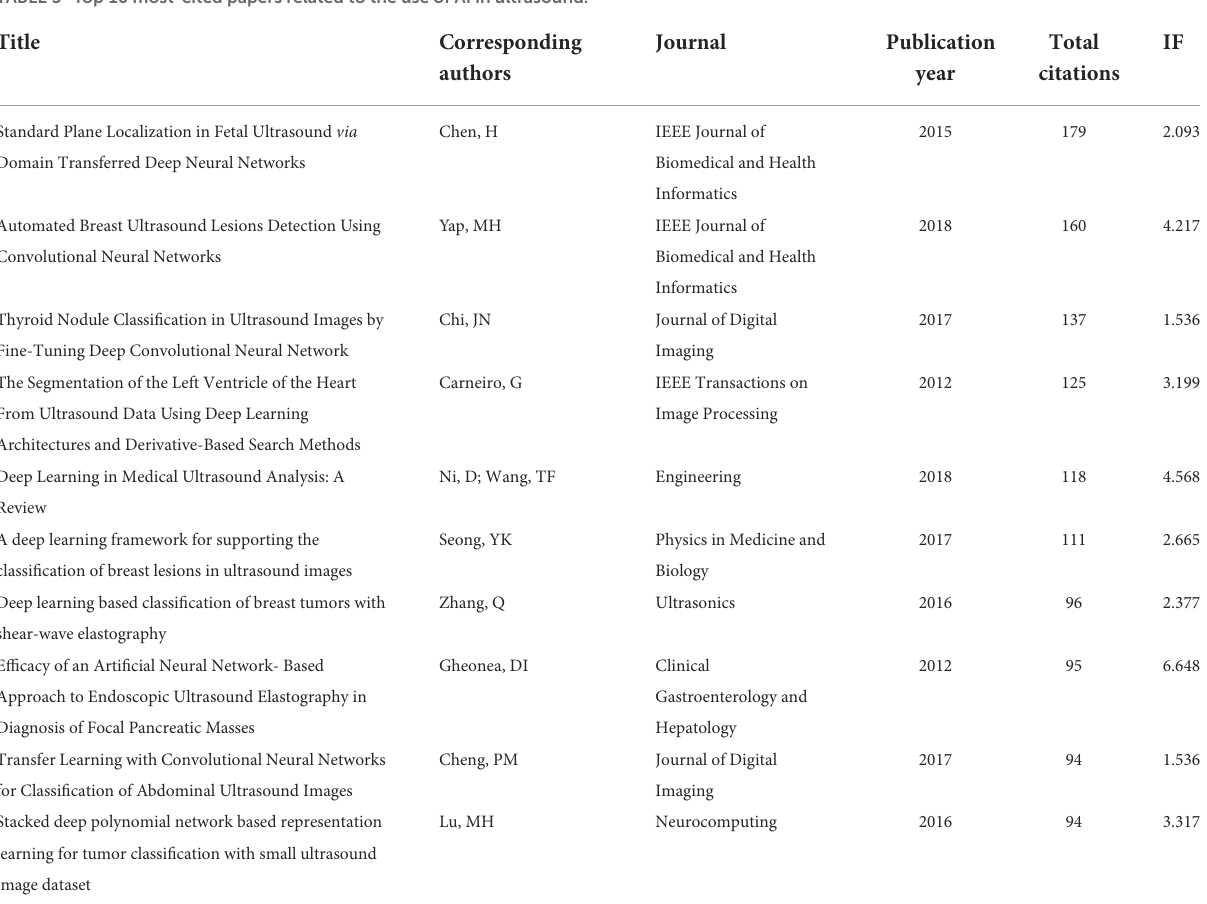
TABLE 5 Top 10 most-cited papers related to the use of AI in